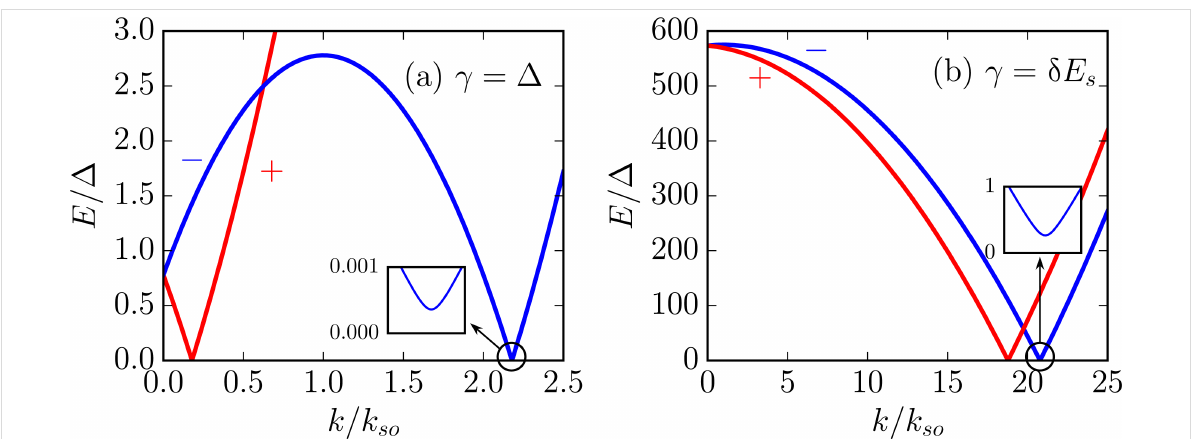
Figure 3: Spectrum of a 2DEG coupled to a thin superconducting layer (see Equation 19) for (a) γ = Δ (corresponding to Γ = 0.9996 and δμ = 0.78 Δ ) and (b) γ = δ E s (corresponding to Γ = 0.735 and δμ = 780 Δ ). When tunneling is weak (as in panel a), the band shift is rather small but the induced gap is negligible. If tunneling is strong enough to open a sizable gap (as in panel b), the band shift is very large (note that the band shift is given by E ± (0) ~ Γδμ rather than δμ ). In both plots, E so = 2 Δ , δ E s = 1000 Δ , μ 2D = 0, k F d/ π = 48.75, and k F z 2D = 0.3. Here k so = m α is the spin–orbit momentum. Note that although, in the insets, we show only the induced gap on the " − "-subband, there is an equally large gap induced on the